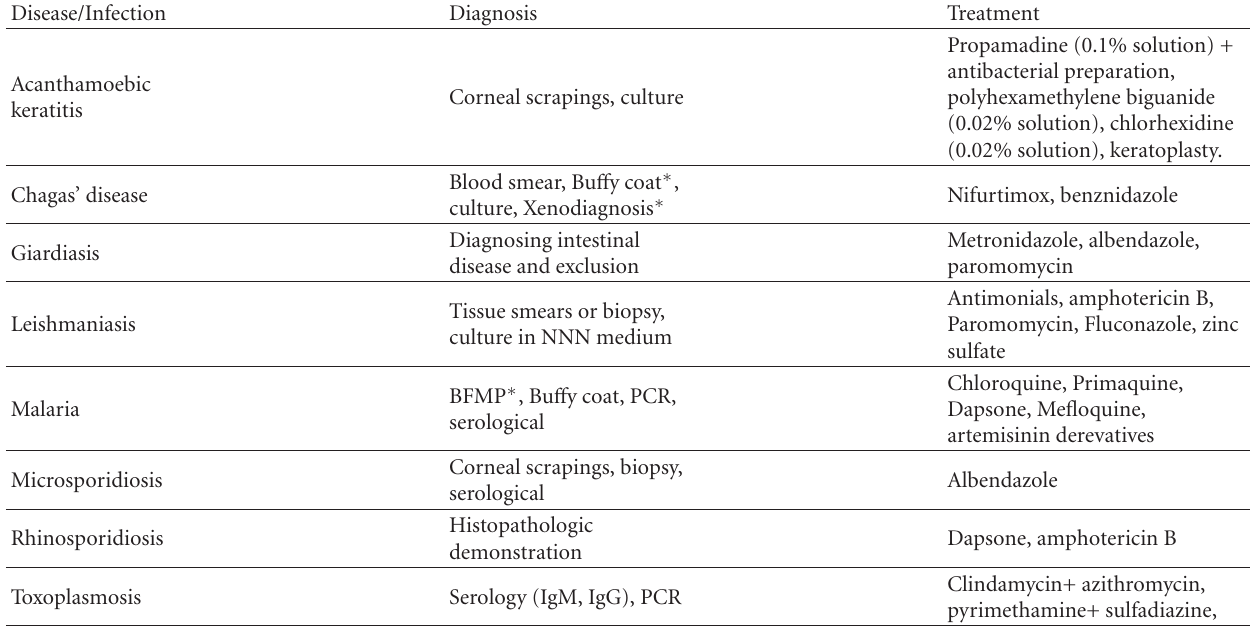
Table 2: Ocular parasitosis caused by protozoa ( diagnosis and treatment